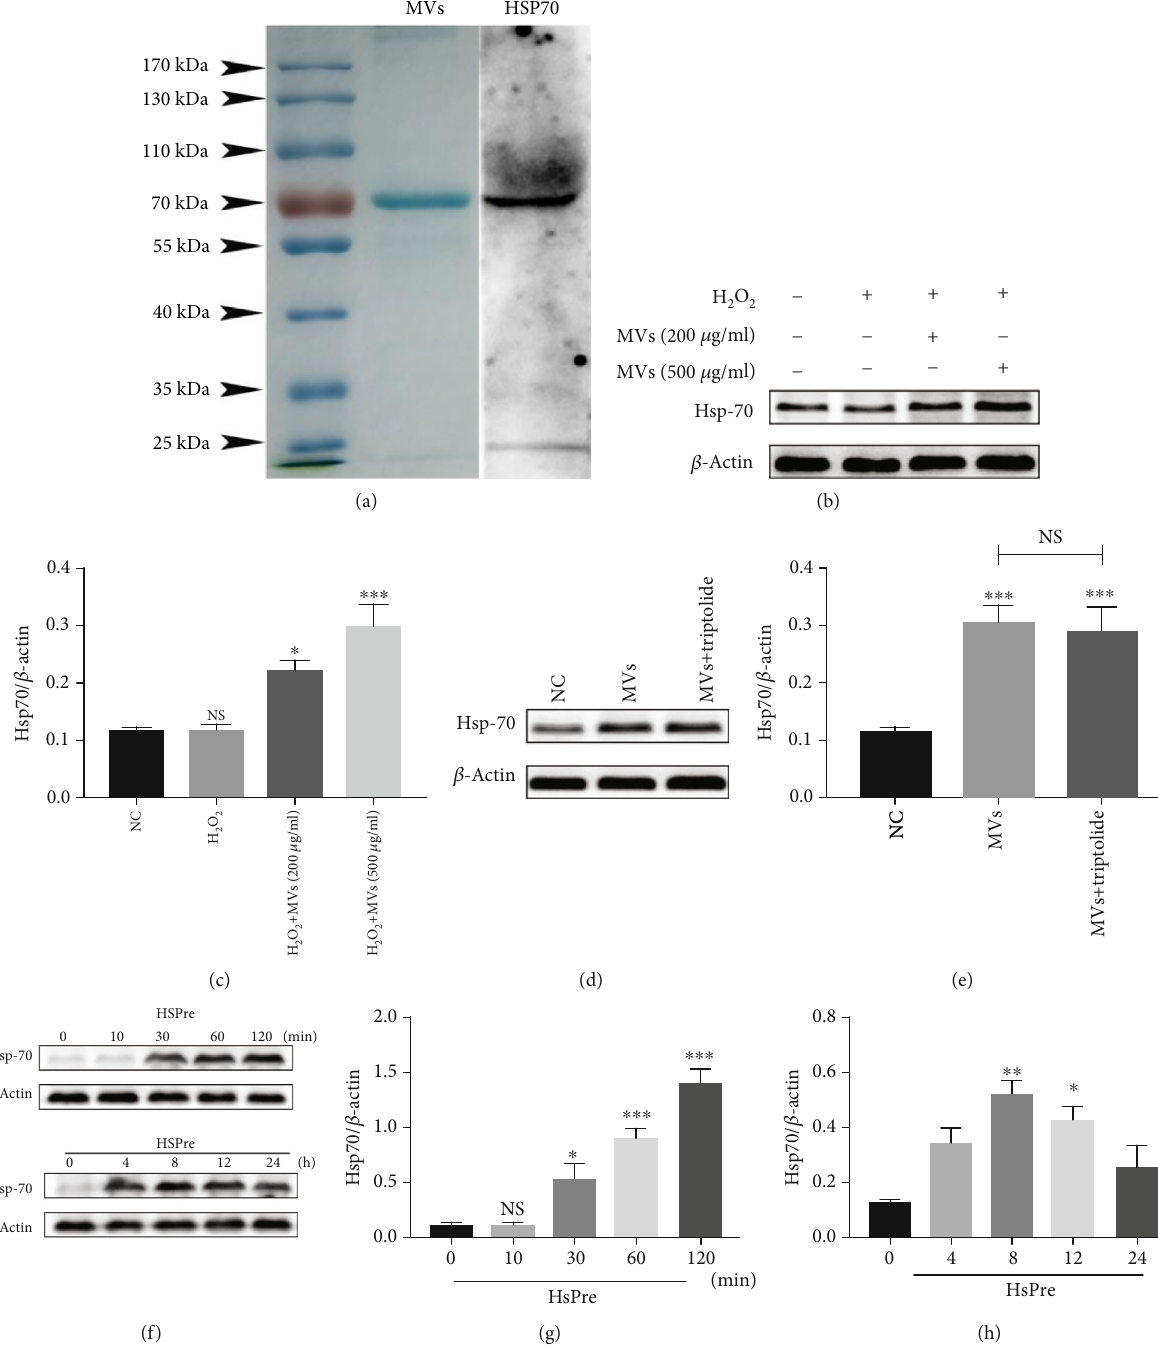
Figure 5: Transfer of HSP-70 between cells via hESC-NSCs-derived MVs. Coomassie blue staining and western blot analysis of protein extracts from MVs (a). Western blot images showing the protein levels of the HSP-70 after HSPre with/without triptolide pretreatment (b – e). Western blot images showing the protein levels of the HSP-70 in HL-1 cells were exposed to 42 ° C for 10, 30, 60, and 120 min and then allowed to recover at 37 ° C for 0, 4, 8, 12, and 24h. β -Actin was used as an internal control (f – h). Every experiment was repeated at least three times. Error bars indicate mean ± SD ( ∗ P < 0 : 05 ; ∗∗ P < 0 : 01 ; ∗∗∗ P < 0 : 001